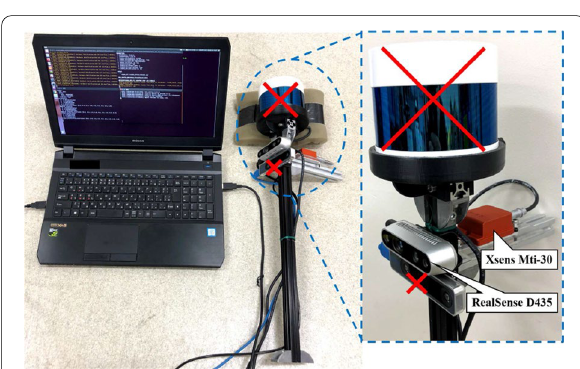
Fig. 3 Sensor stick. Images and acceleration are recorded with this stick when it is still. The judge whether it is still is processed by programing. Note that depth information is not used in this study although RealSense D435 is a RGB-D camera